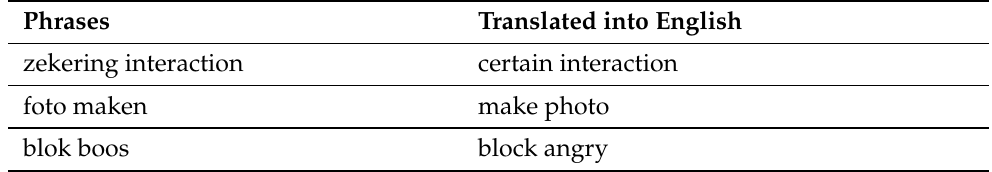
Table 4. Bigrams of the teacher with high tf-idf ranking (i.e., bigrams rarely